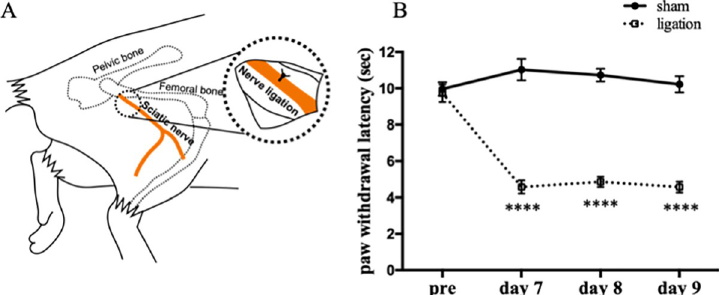
Fig 1. Change of thermal hyperalgesia in neuropathic pain model mice. Schematic diagram of sciatic nerve ligation (A). Plantar tests were performed before nerve ligation surgery, 7, 8 and 9 days after surgery. Data are expressed as means ± SEM. Data are analyzed using two-way ANOVA followed by Bonferroni’s post hoc test and considered statistically significant at ���� P < 0.0001 when comparing the sham (n = 8) and nerve ligation groups (n = 8) (B).